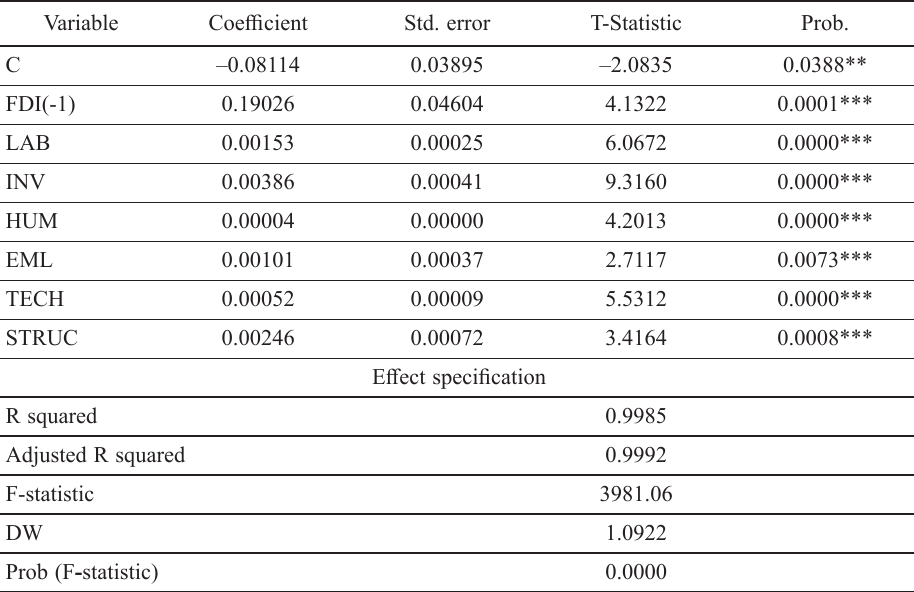
Table 4. Fiscal decentralization effect on economic growth in ES-21 countries